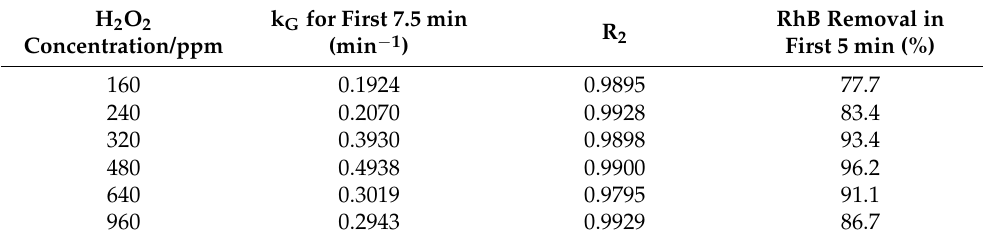
Figure 7. Catalytic degradation of RhB under different H 2 O 2 concentration ( a ) plots of pseudo-first-order kinetics; ( b ) RhB concentration. Table 4. The influence of H 2 O 2 concentration on k G for the first 7.5 min and RhB removal in the first 5 min.